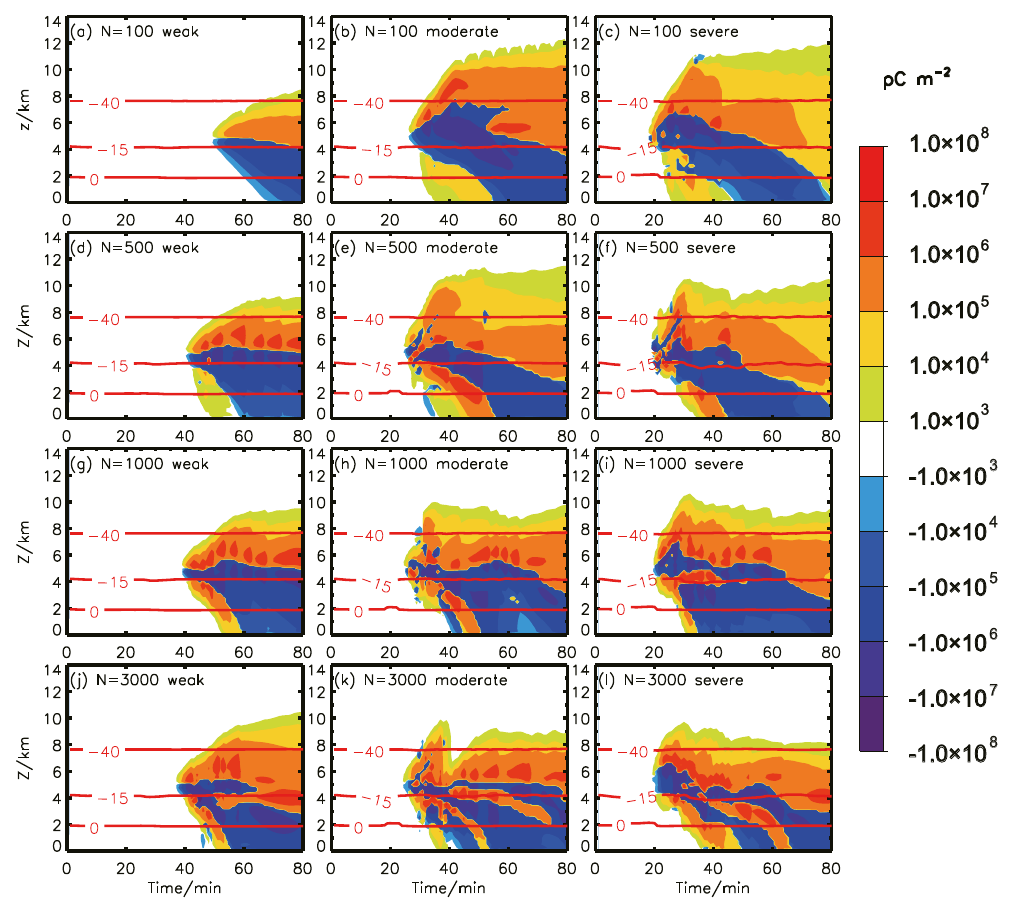
Figure 13. The evolution of charge structure; red solid line represents the isotherm ( − 40 and − 15 ◦ C and to 0 ◦ C; ( a – c ) N 0 = 100 cm − 3 ; ( d – f ) N 0 = 500 cm − 3 ; ( g – i ) N 0 = 1000 cm − 3 ; ( j – l ) N 0 = 3000 cm − 3 .